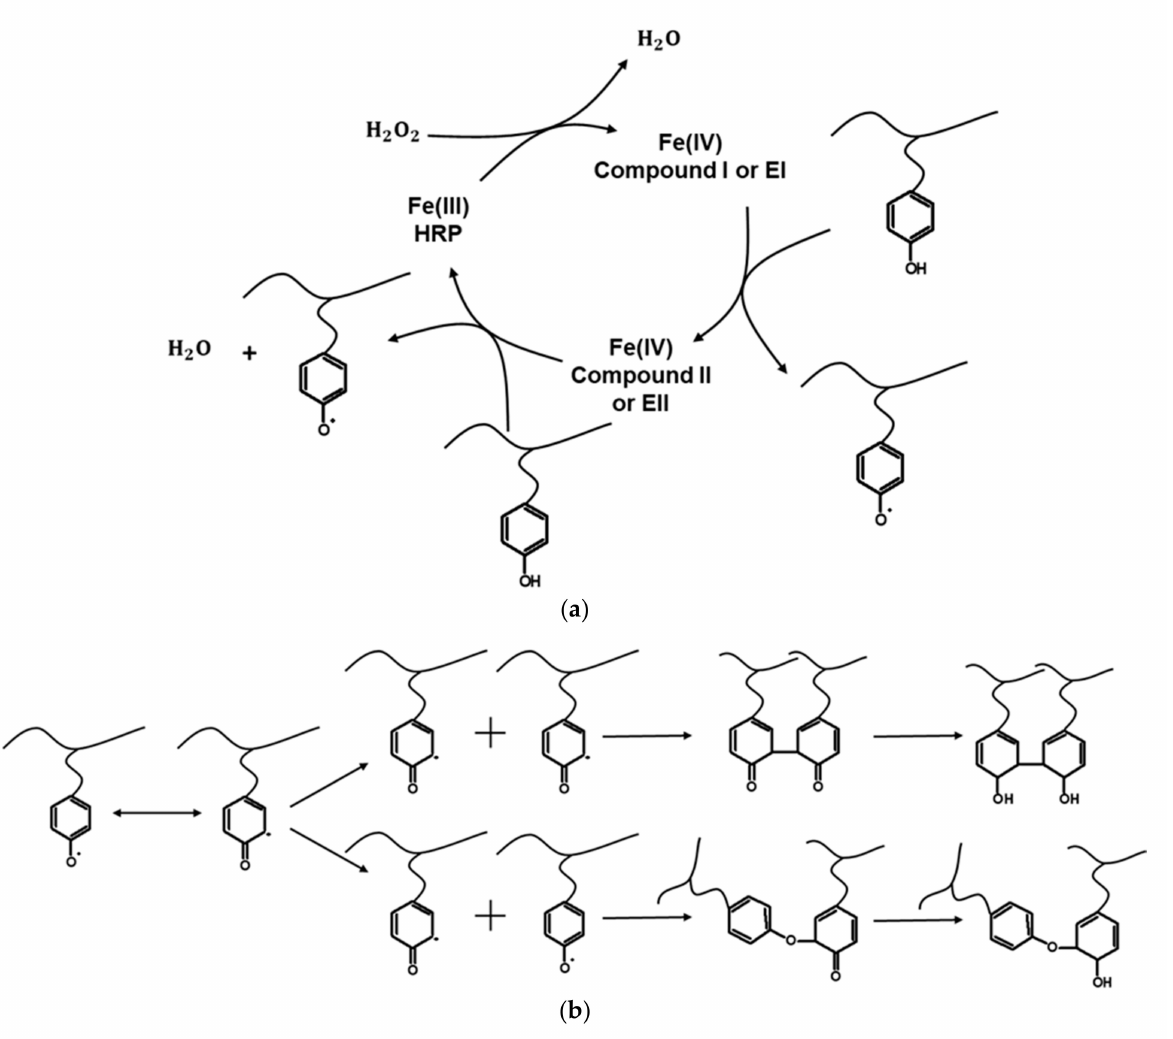
Figure 1. ( a ) Activation of polymer–phenol conjugates in the presence of the HRP enzyme and hydrogen peroxide. ( b ) Isomerization of phenolic radicals and crosslinking reactions between different types of “live” polymer chains and enolization of crosslinked polymer chains (adapted from reference